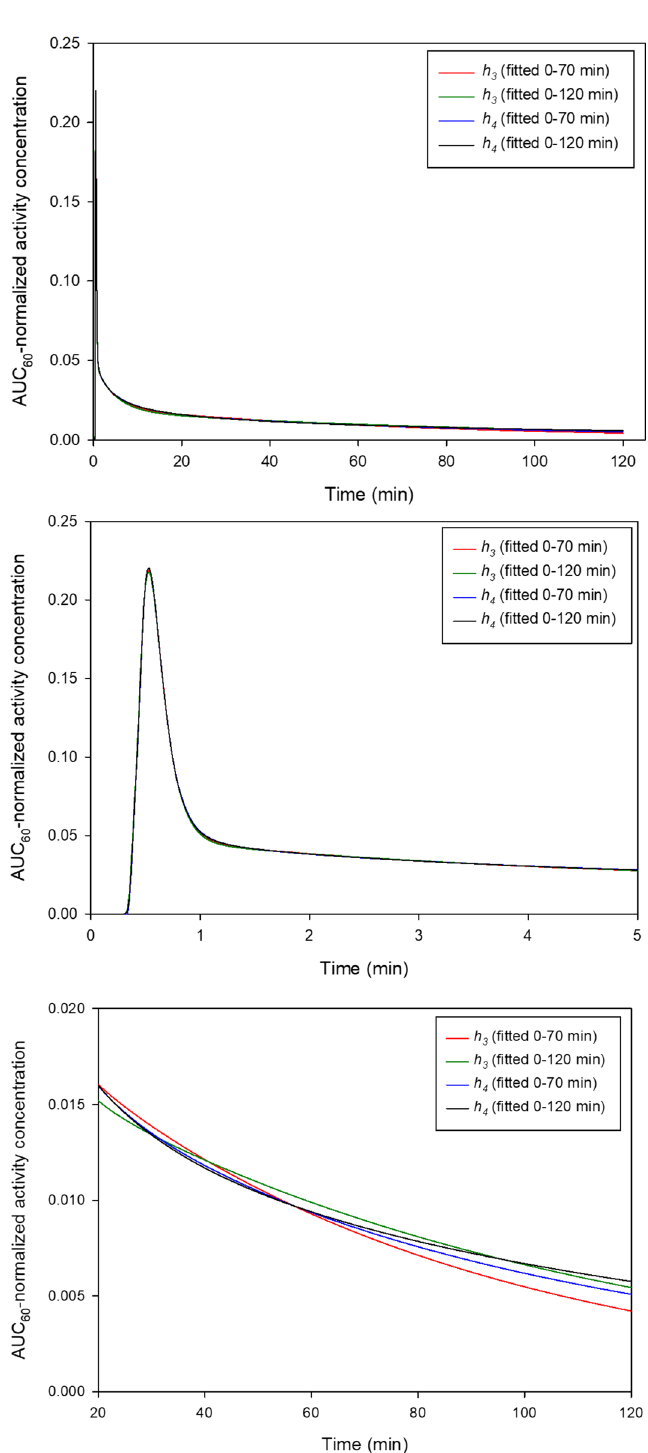
Fig. 2 Three plots of the four PBIF shown at different time scales. Top: The four PBIFs are look almost identical on the full time-scale up to 120 min. Middle: The PBIFs have completely overlapping shapes of initial dynamic phase following the tracer infusion as modelled with the first exponentials. Bottom: After 20 min, the shapes are markedly different as modelled by the late